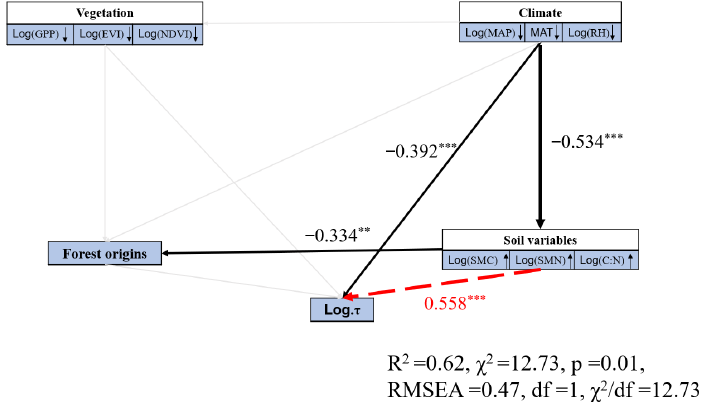
Figure A12. The main influencing factors of C turnover in the subsoil of EBF were obtained by the SEM model. The symbols “ ↑ ” and “ ↓ ” indicate a positive or negative correlation between environmental factors and subsoil τ . The goodness of fit statistics for the effect size model of the relationship are as follows: ** p < 0.01, *** p < 0.001.